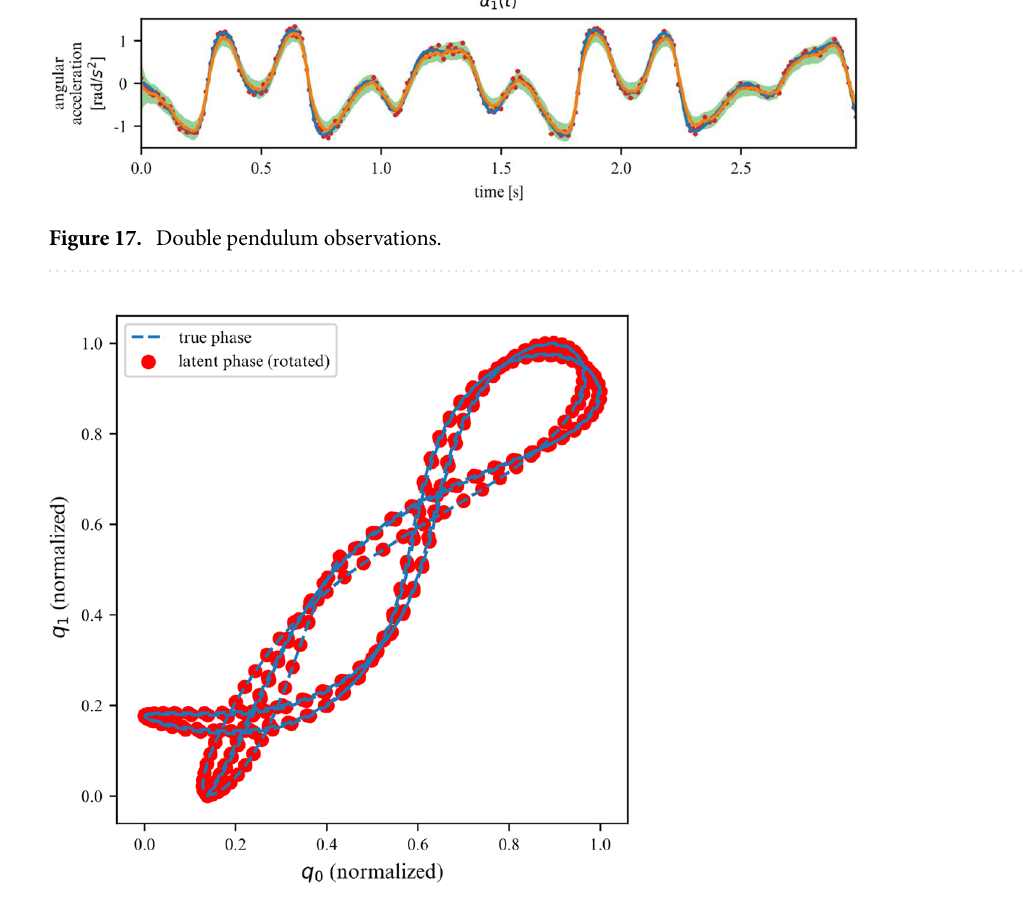
Figure 18. Double pendulum phase